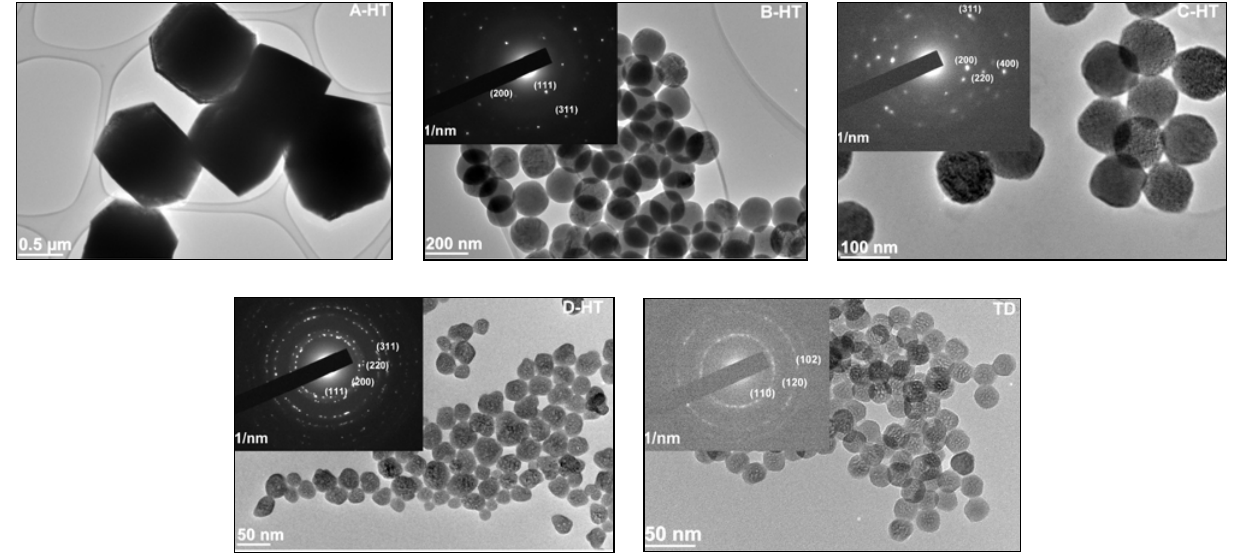
Fig. 3: TEM images of the as-synthesized UCNPs. The corresponding SAED are indexed according to α -NaYF and β -NaYF (TD). 4